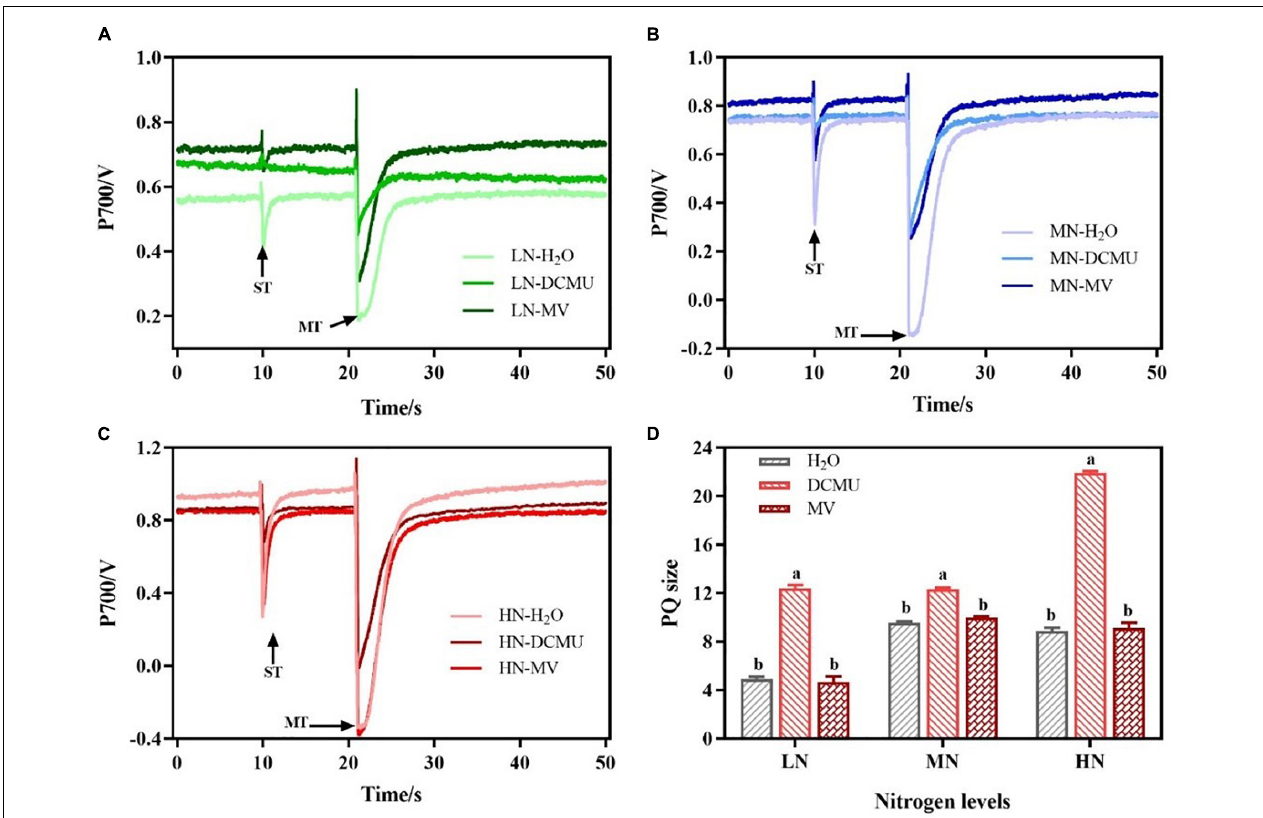
FIGURE 8 | Effects of 3-(3,4-dichlorophenyl)-1,1-dimethyl urea (DCMU) and methyl viologen (MV) on plastoquinone (PQ) in leaves of Panax notoginseng grown under different nitrogen regimes. Panels (A–C) represent the nitrogen (N) levels of LN, MN, and HN, respectively. Panel (D) is the PQ pool size. Values for each point were mean ± SD ( n = 5). Letters indicate significant differences at p < 0.05 according to Duncan’s multiple range tests. ST, single-turn saturation pulse; MT, multi-turn saturation pulse; LN, low N; MN, moderate N; HN, high